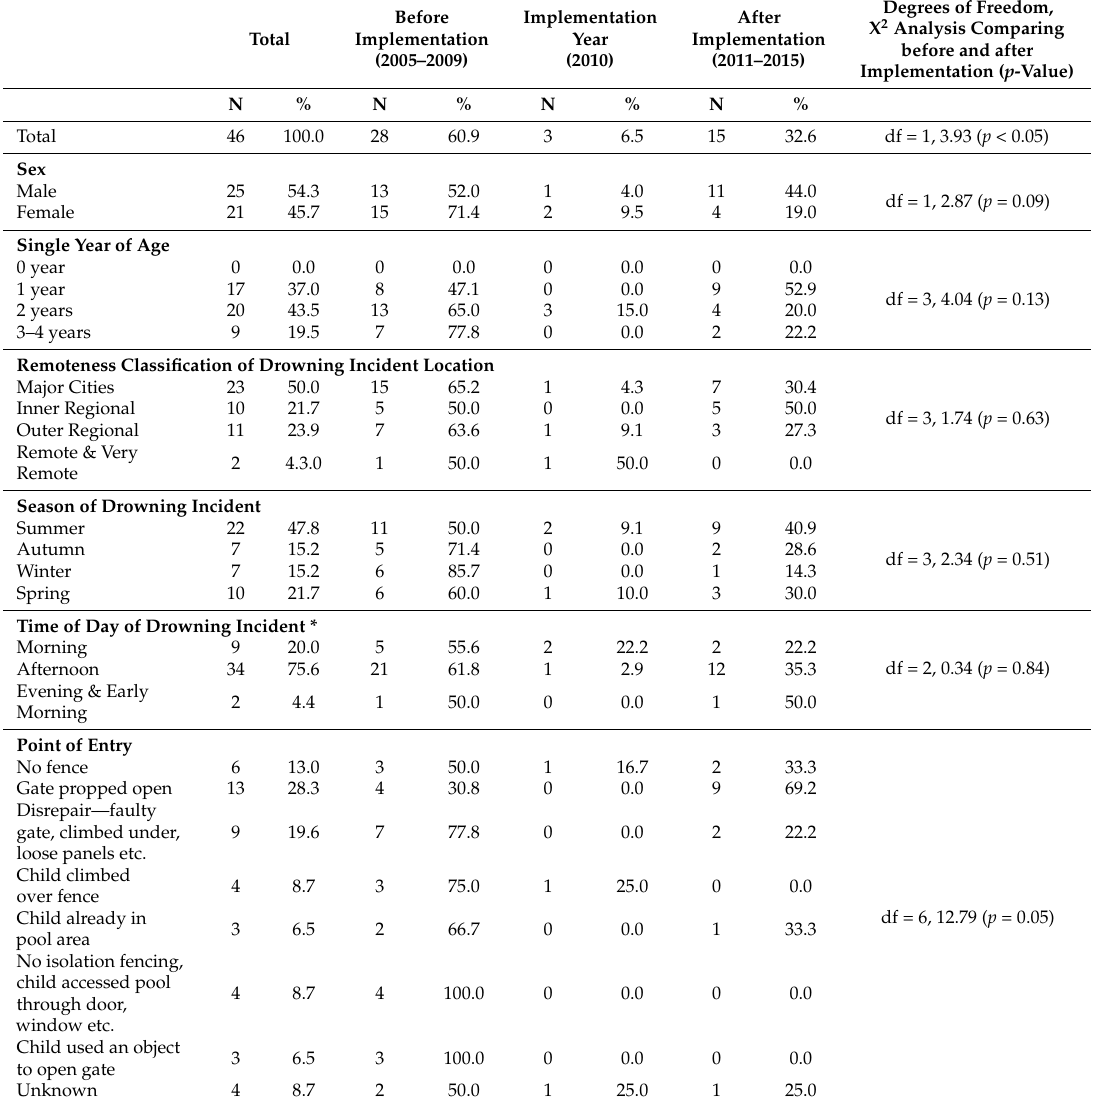
Table 3. Drowning deaths of children aged 0–4 years in private swimming pools by sex, single year of age, pool type, remoteness classification of drowning incident location, season of drowning incident, time of day of drowning incident, activity immediately prior to drowning, and point of entry to pool, Queensland, 2005–2015 ( N =